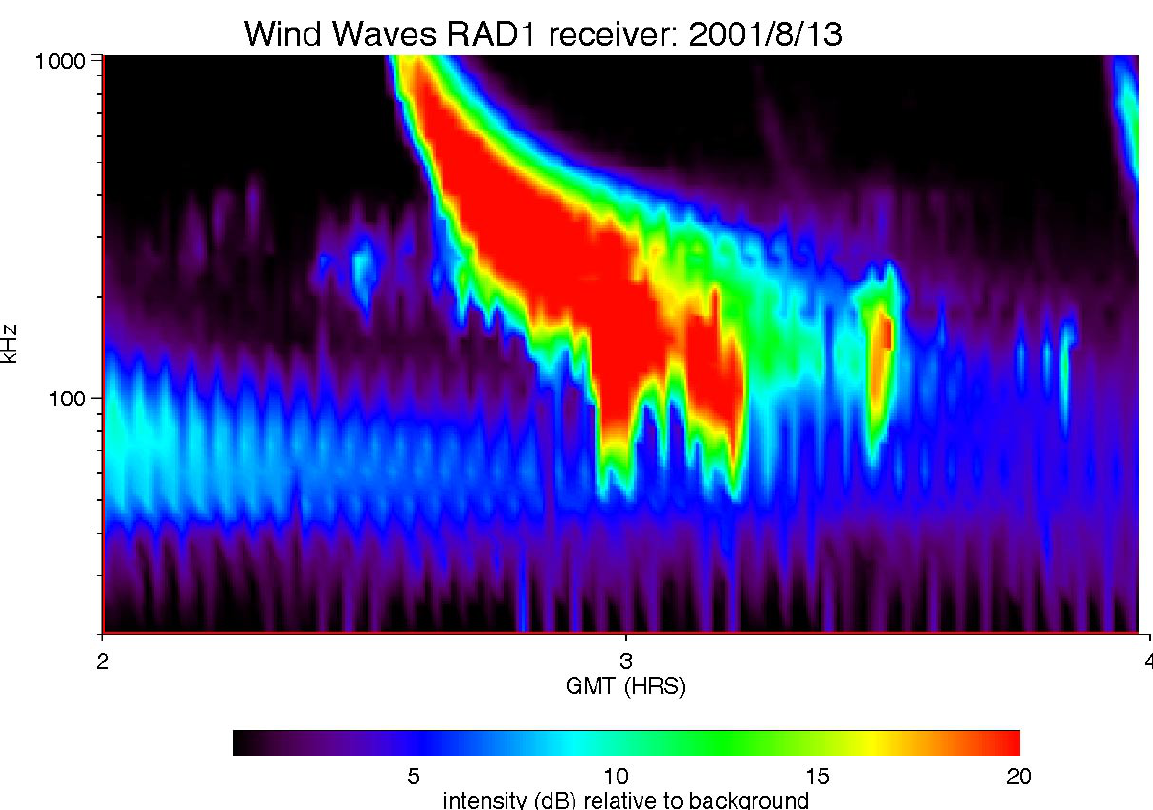
Fig. 3. A frequency spectrogram of the RAD1 receiver on the Waves experiment on board the Wind spacecraft for the period 02:00 UT to 04:00 UT on 13 August 2001. Onset of auroral kilometric radiation occurs at ∼ 02:55 UT with an enhancement of the intensity of the wave activity at ∼ 60 to